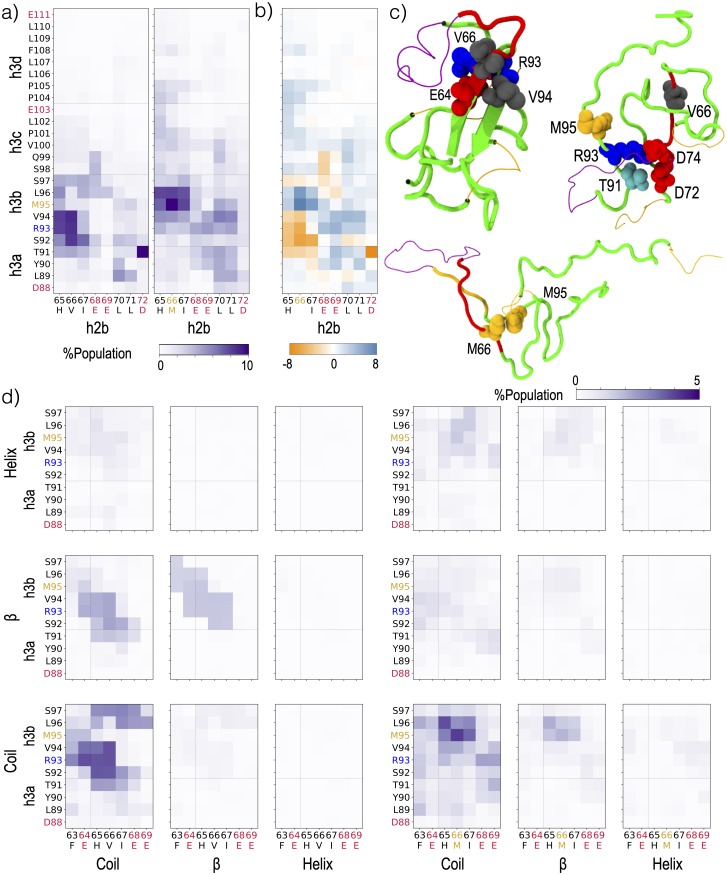
Effect of secondary structure in group h2 on which residues form the cross-boundary h2-h3 contact.a) Contact probability at each residue in h2b with each residue in h3 for V66 (left) and M66 (right) sequences. b) Difference (M66-V66) between the contact probabilities shown in panel a. c) Representative conformations of V66 sequence (top) and M66 sequence (bottom) showing preferred residue-level contacts in VDW representations. Residues are colored by residue type: blue:basic, red:acidic, cyan:polar, grey:hydrophobic except methionine, Met: yellow. The chain is colored according to the Das and Pappu diagram in Fig 1c. Tubes represent hydrophobic “h” blobs whereas lines represent non-hydrophobic linker “p” blobs. d) Contact probability between residues 63-69 and each residue in h3ab, when respective secondary structure is formed at each residue, for both the V66 (left) and M66 (right) sequences. Residue labels are colored according to residue type: blue:basic, red:acidic, grey:hydrophobic/polar and Met: yellow.